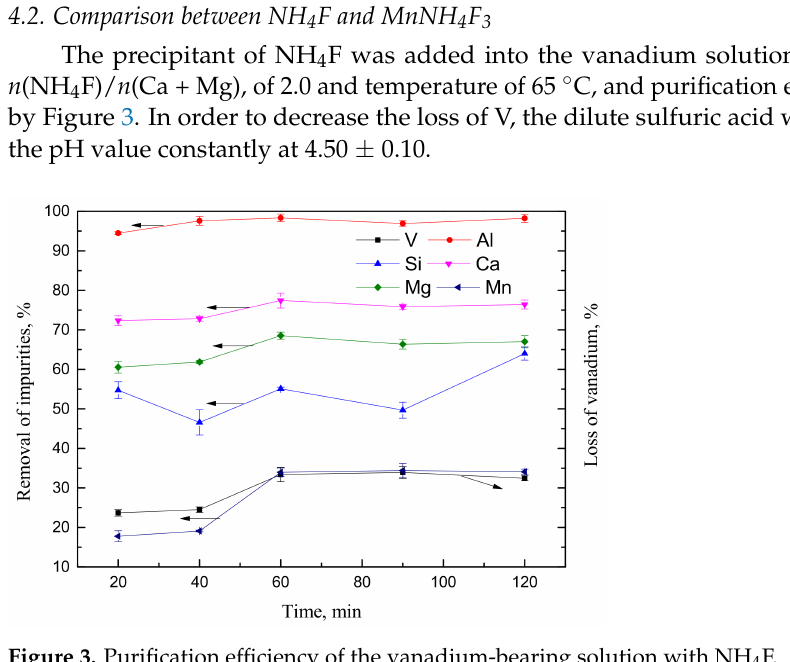
Figure 3. Purification efficiency of the vanadium-bearing solution with NH 4